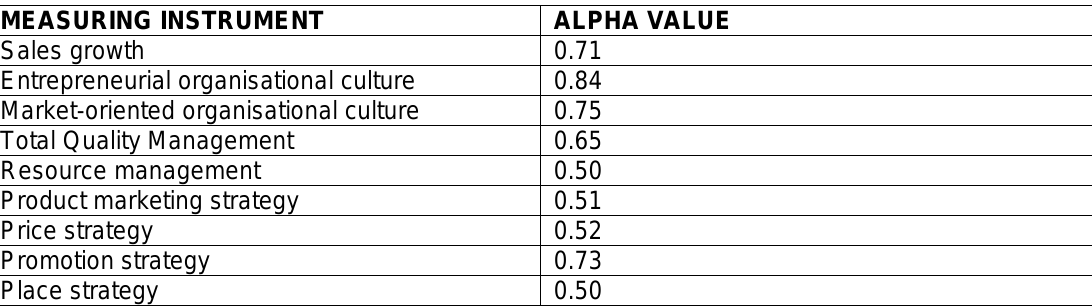
Table 2: cronbach alpha values of measuring instruments MEASURING INSTRUMENT